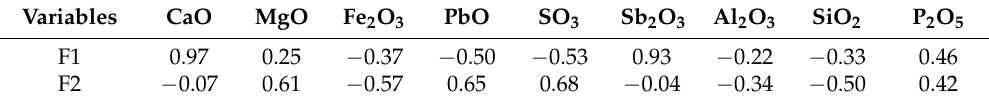
Table 1. Factors F1 and F2 and the correlation coefficients among main